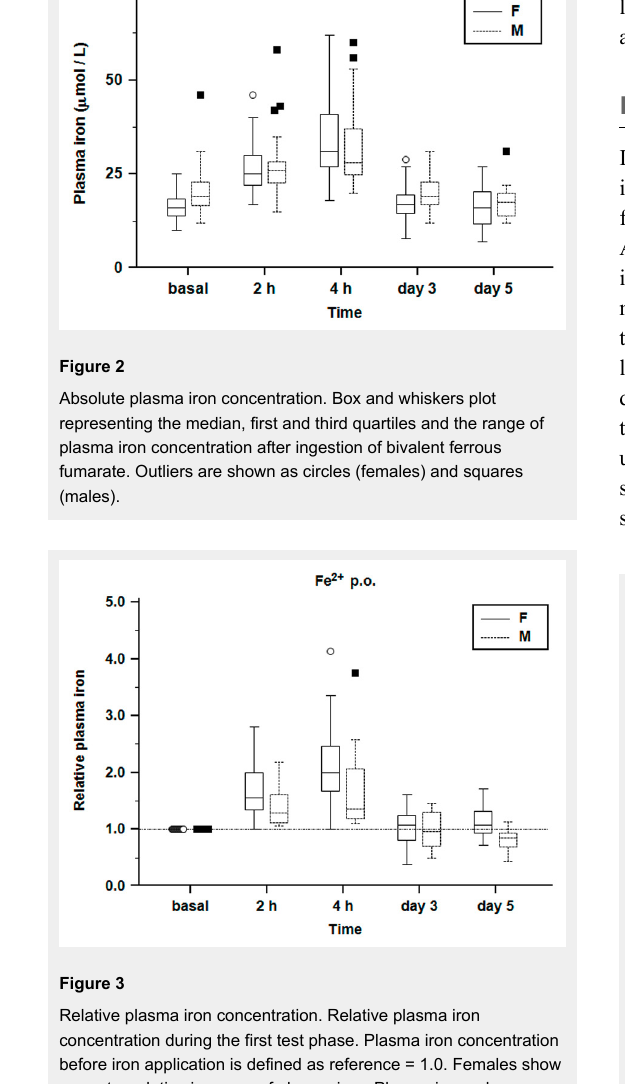
Correlation of initial ferritin and relative plasma iron concentration. Lower initial ferritin is correlated with a greater relative plasma iron increase. In general, females show lower ferritin values compared to